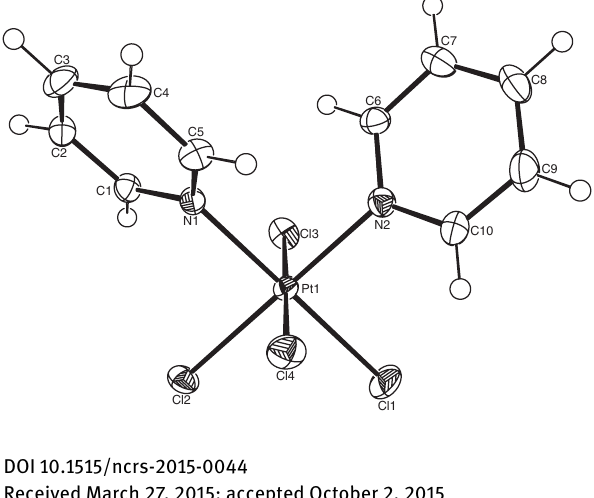
Table 1: Data collection and handling.